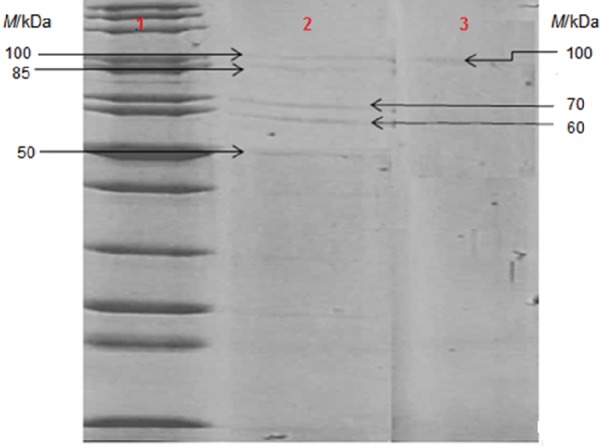
Sodium dodecyl sulfate-polyacrylamide gel electrophoresis (SDS-PAGE) for tested collagen. Legend: from left to right – column 1=molecular mass standards, column 2=collagen powder, column 3=collagen fibre